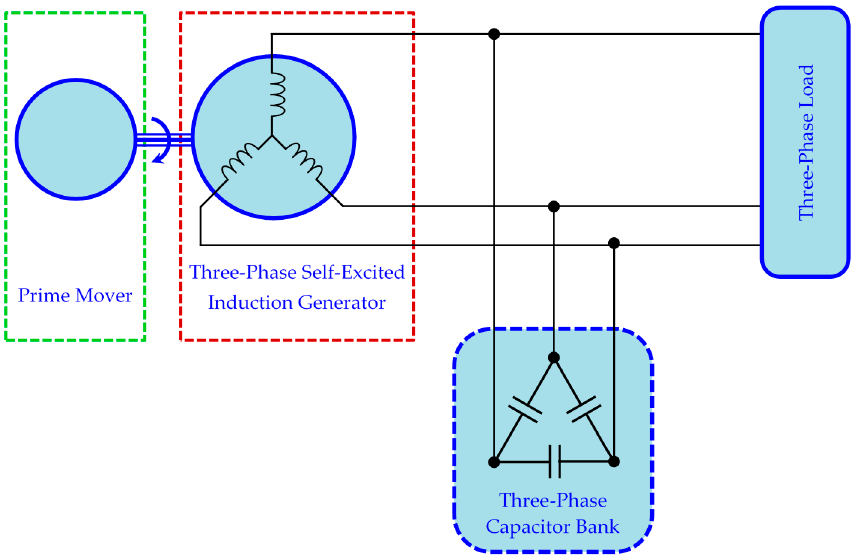
Figure 1. Schematic diagram of the system under study.